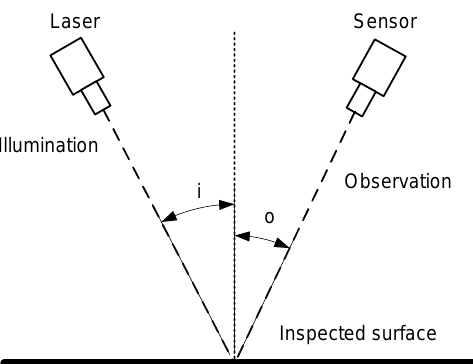
Figure 1. Principle of triangulation